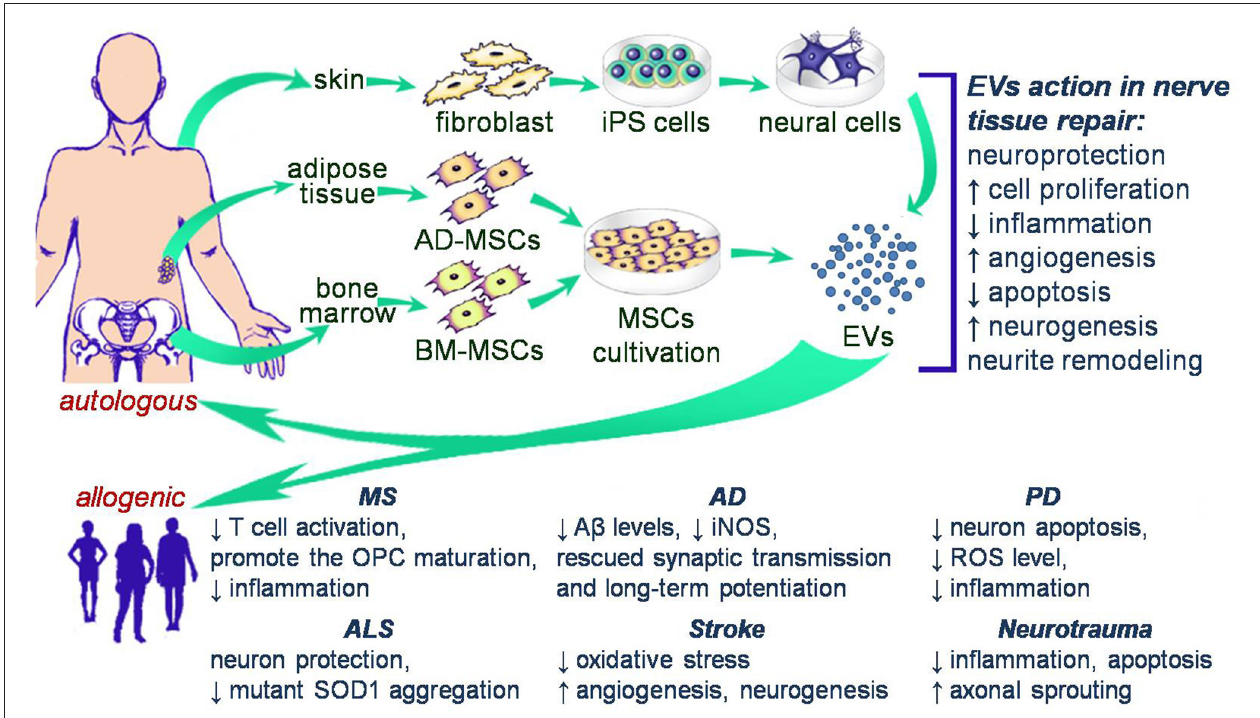
FIGURE 1 | Schematic illustration of potential cell free therapy in clinical trials of nerve